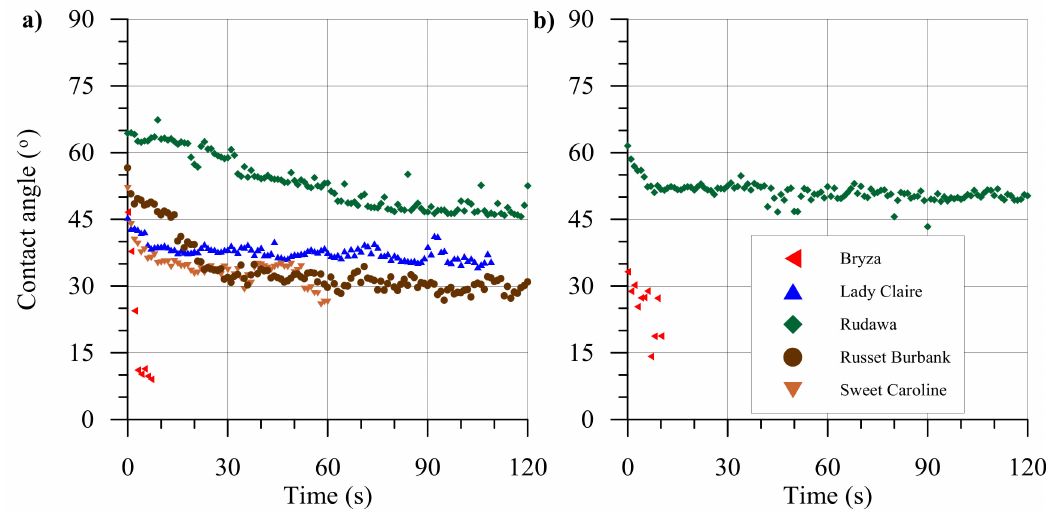
Figure 1. Examples of contact angle measurements for a single distilled water drop on leaves of five potato cultivars over 120 s. Leaves were collected in 2018 ( a ) and in 2019 ( b ). The measured contact angle values divided into the initial contact angle, the final contact angle, and the change of the angle value over the time of 120 s, as well as the results of the analysis of the variances between cultivars, are presented in Figure 2. In both years, the highest contact angle values were found for the Rudawa cultivar. For this cultivar, both the initial contact angle (i.e., measured after 1 s) and the final contact angle (measured after 120 s) were the highest among all the cultivars. In fact, this cultivar was characterized by the smallest change in the contact angle value. The droplet behaved the most stably during the measurement, i.e., for 2 minutes, compared to the other cultivars. In turn, the highest contact angle change over time was observed for Russet Burbank cultivar. The lowest ◦ contact angle values were found for the Bryza cultivar (initial contact angle < 30 ). In the case of this cultivar, the droplet spread over the leaf surface quickly within the 2 minutes. Analyses of the initial contact angles for all potato cultivars revealed that only Lady Claire and Russet Burbank showed no statistically significant di ff erences. In turn, the final contact angle values were not significantly di ff erent between Bryza and Sweet Caroline. In both cases, the droplets spread faster than the measurement could detect (water droplets spread over the leaf surface and complete wetting